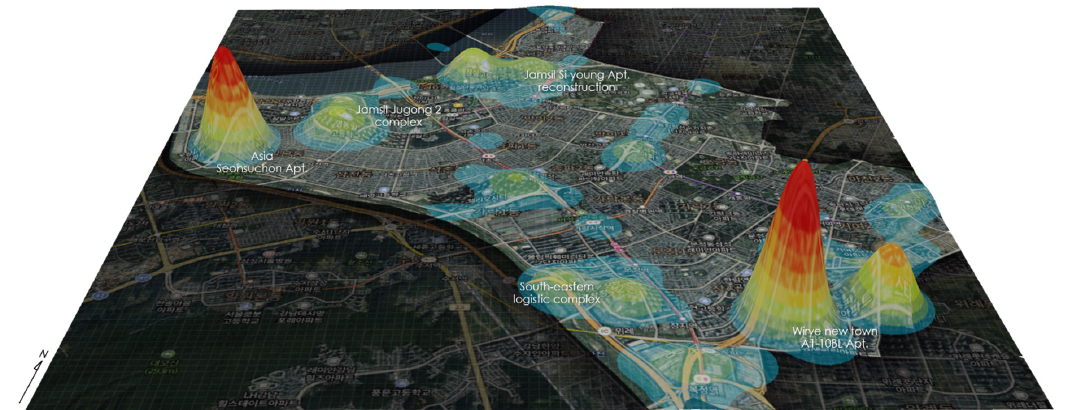
Figure 7. Borehole density in the study area